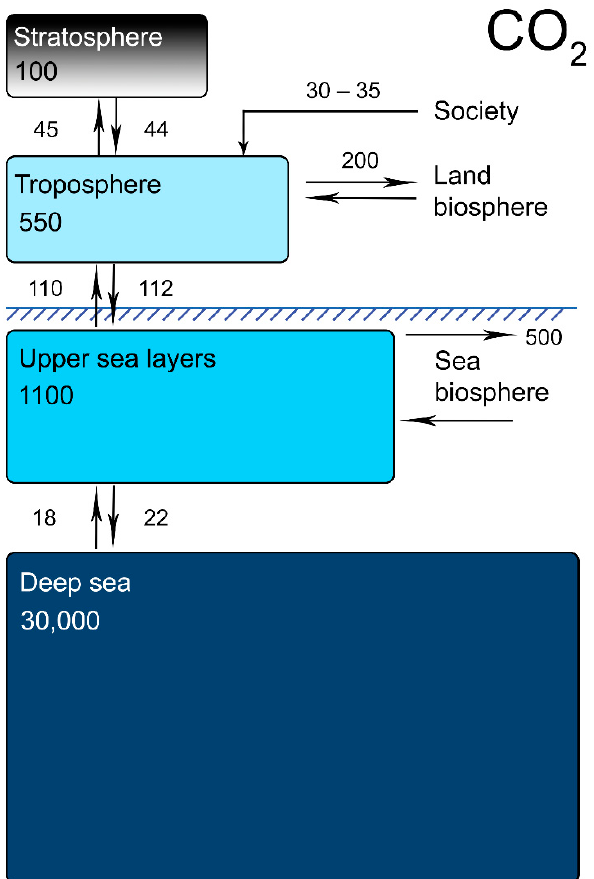
Figure 1. The largest natural reservoirs of carbon dioxide (billion tons) and carbon dioxide fluxes (billion tons per annum). Based on the data provided in [18–21].